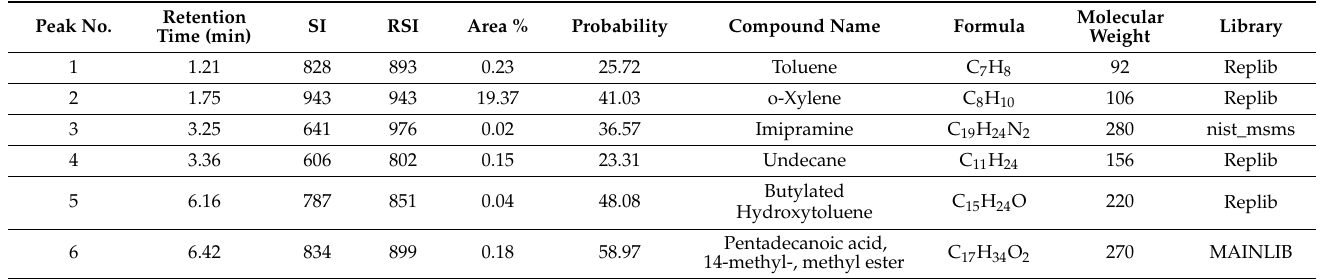
Table 1. Bioactive compounds identified in methanolic extract of Chrozophora tinctoria by GC-MS. Peak